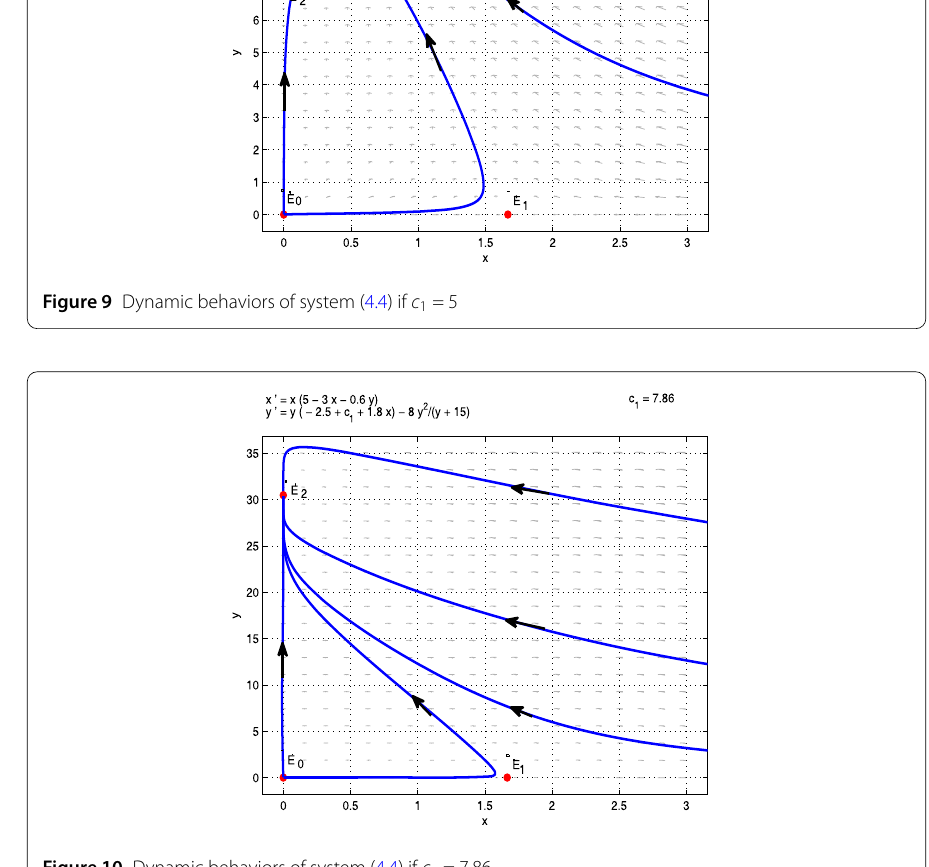
Figure 10 Dynamic behaviors of system (4.4) if c 1 =